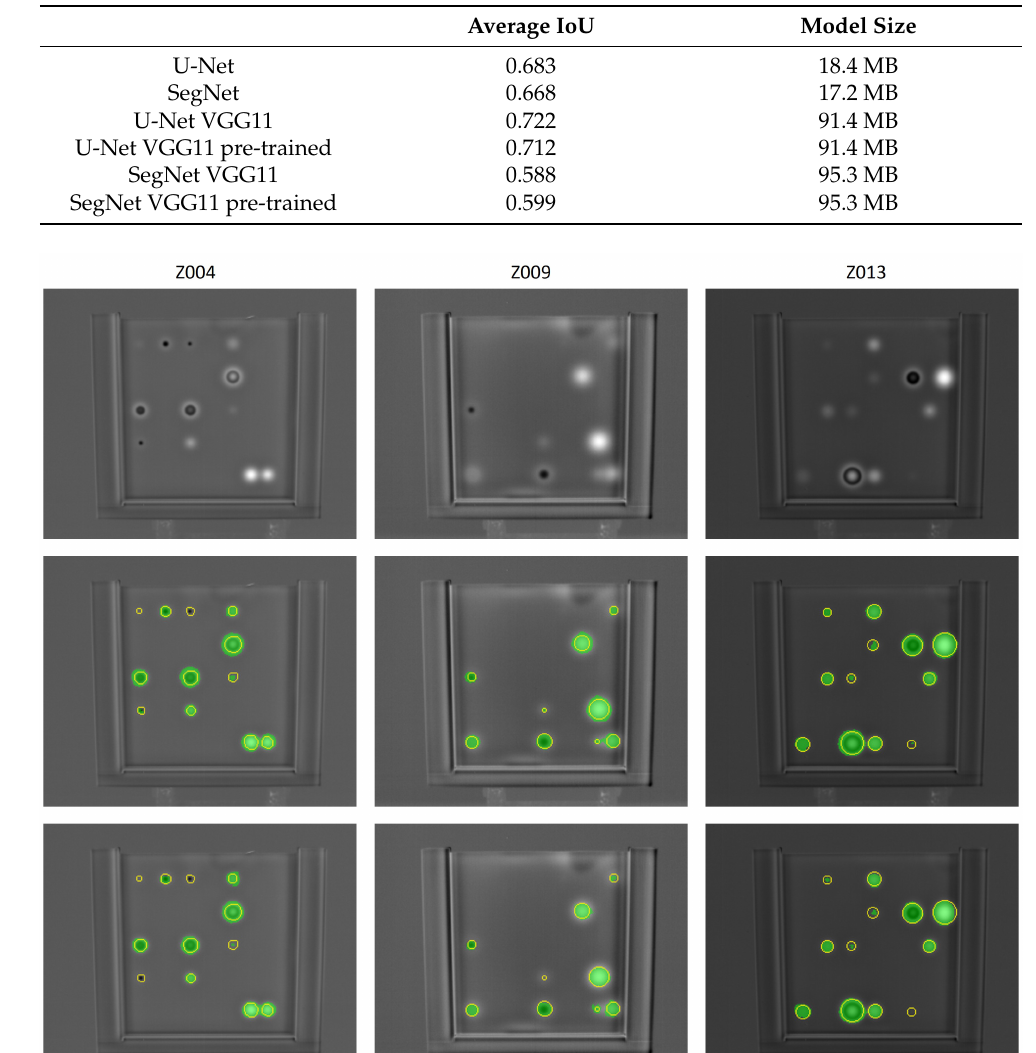
Table 1. Results on the original test dataset.